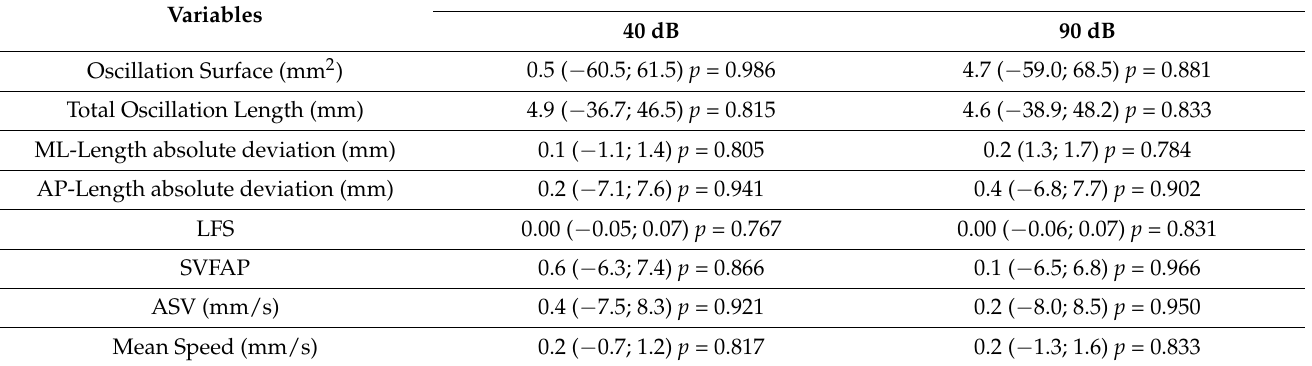
Table 4. Static posturography score differences between acoustic conditions.